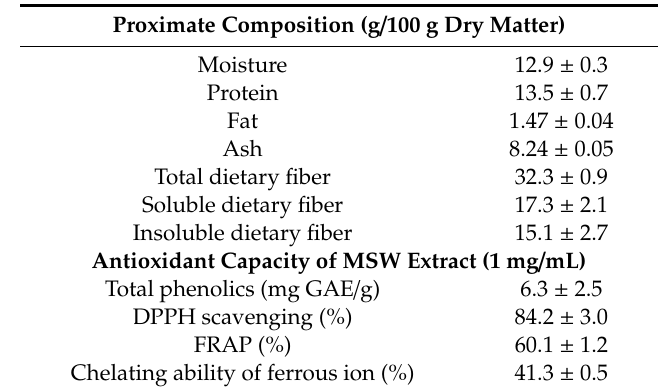
Table 2. Proximate composition (mean values ± SE) and antioxidant activity of enoki mushroom stem waste powder /